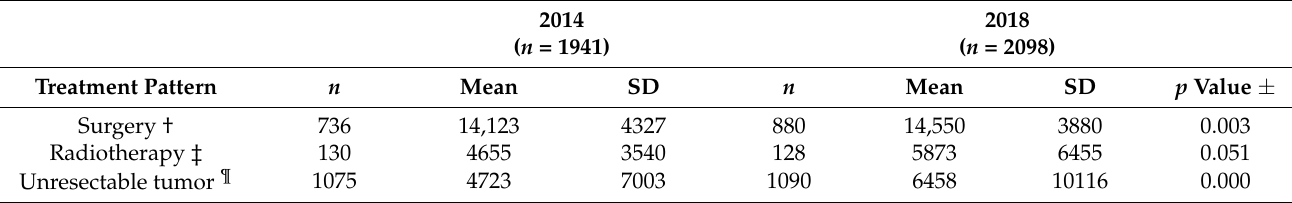
Figure 2. Kaplan – Meier curve for estimating overall survival for those who received first treatment in 2014 and 2018 by treatment pattern. NR: not reached. Global: patients who receive any of the treatments described below. Surgery: patients receiving surgery with a curative intent with or without neoadjuvant and/or adjuvant pharmacological treatment, and/or complementary radiotherapy; also includes different lines of treatment for tumor recurrence. Radiotherapy: patients with radiotherapy with a curative intent, with or without pharmacological treatments; also includes different lines of treatment for tumor recurrence. Unresectable tumor: patients who only receive pharmacological treatments with a palliative intent. Without systemic therapy: patients who do not receive any of the treatments described above. Table 4. Mean cost (EUR) of the first year of treatment in 2014 and